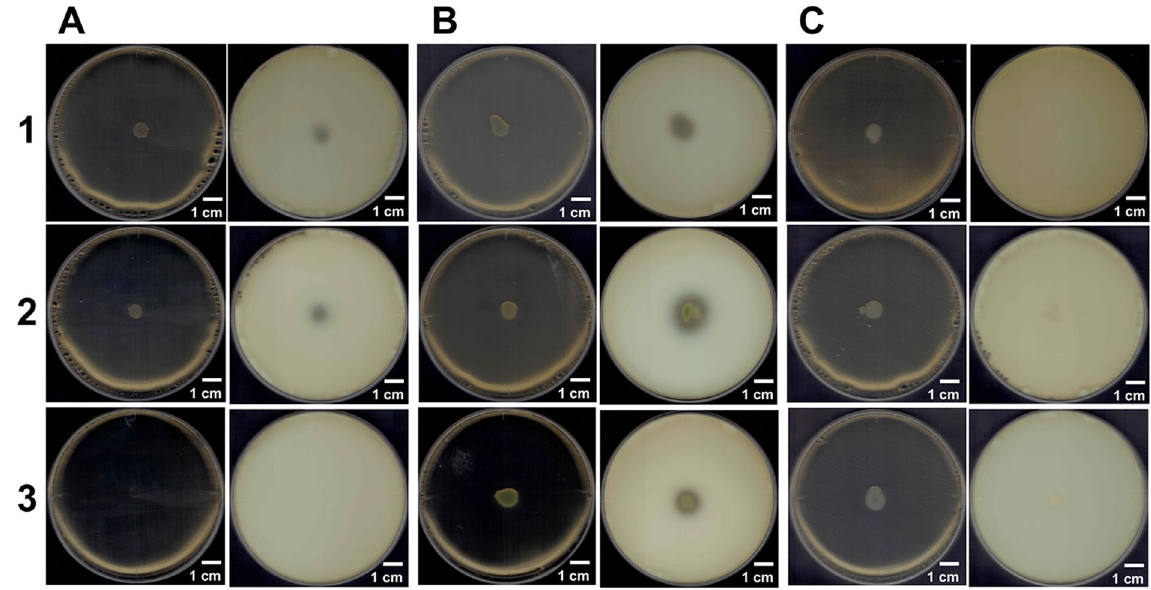
Figure 3. Degradation of GAGs. ( A ) S. moniliformis . ( B ) P. heparinus as a positive control. ( C ) E. coli as a negative control. Plates on the left and right represent before and after addition of acetic acid, respectively.